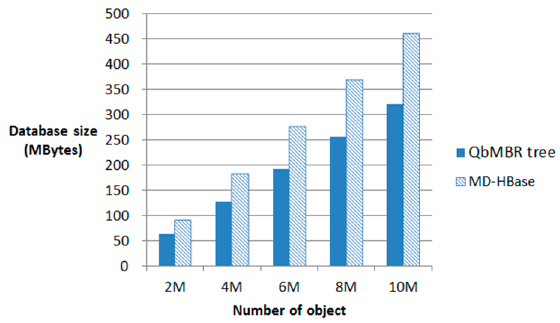
Figure 7. Size of a